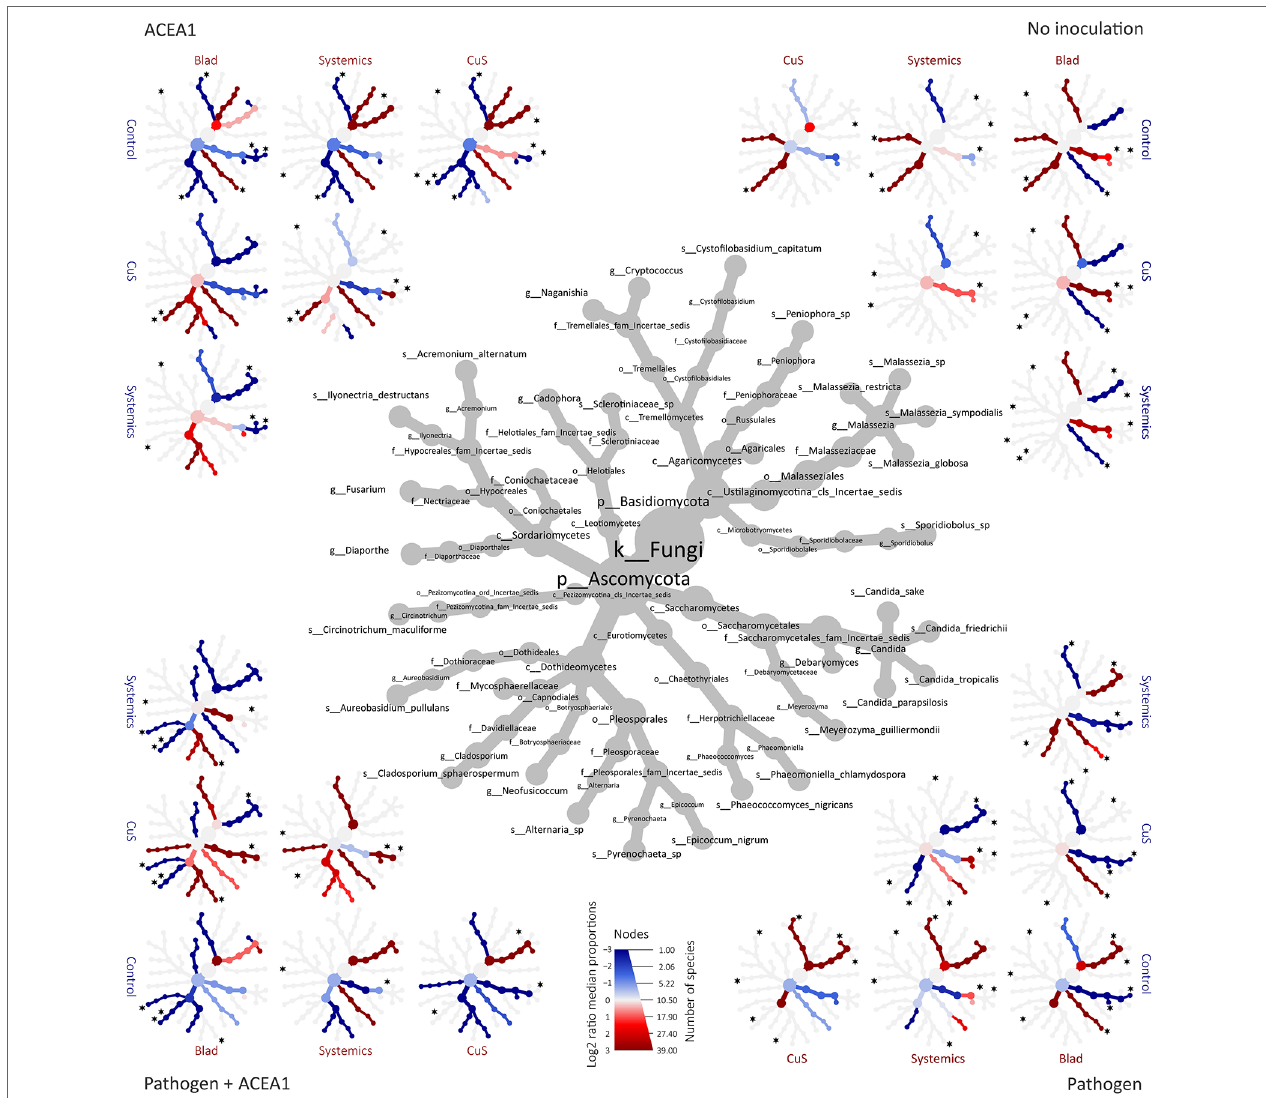
FIGURE 7 | Differential heat tree matrixes depicting the change in taxon abundance between different fungicide treatments, represented in the dataset with a relative abundance (RA) > 0.1% ( n = 5 for each combination inoculum/treatment). The size of the individual nodes in the gray cladogram depicts the number of taxa identified at that taxonomic level. The smaller cladograms show pairwise comparisons between each treatment, with the color illustrating the log2 fold change: a red node indicates a lower abundance of the taxon in the treatment group stated on the abscissa than in the treatment group stated on the ordinate. A blue node indicates the opposite. A black star next to a node represents the statistical differences according to DeSeq2 ( P 0.05), for the most frequent taxa ( Table 2